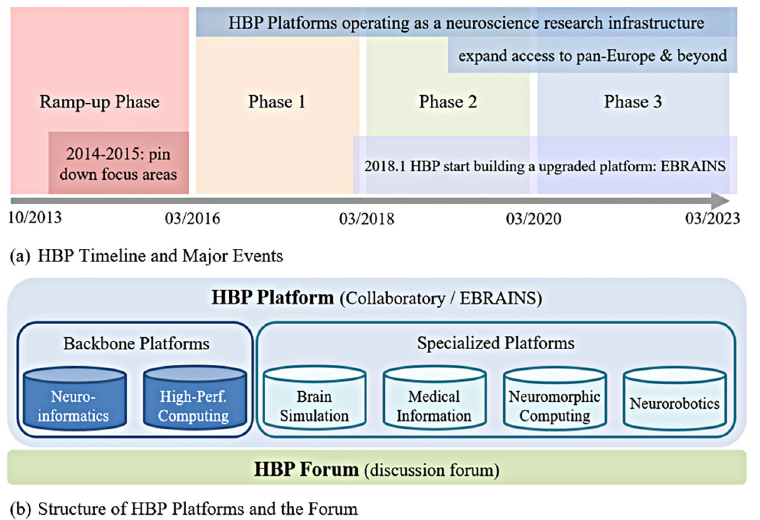
Fig 1. The organization of the HBP platforms and the HBP Forum. Notes: Author’s graph. Panel (a) depicts major milestones in the HBP timeline. Panel (b) provides an overview of the different AI-powered platforms built during the HBP and the broad relationship with the HBP Forum. While accessing certain areas within the HBP platforms requires additional authorization, the HBP Forum is publicly accessible and allows for decentralized knowledge sharing across the globe. Sources: https://www.humanbrainproject.eu/en/ and https://forum.humanbrainproject.eu/.